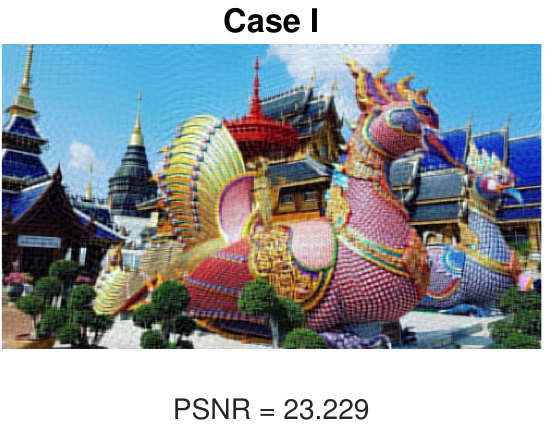
Figure 18. The reconstructed grey image with their PSNRs for three different cases using the proposed algorithm presented in 10,000 iterations, respectively.